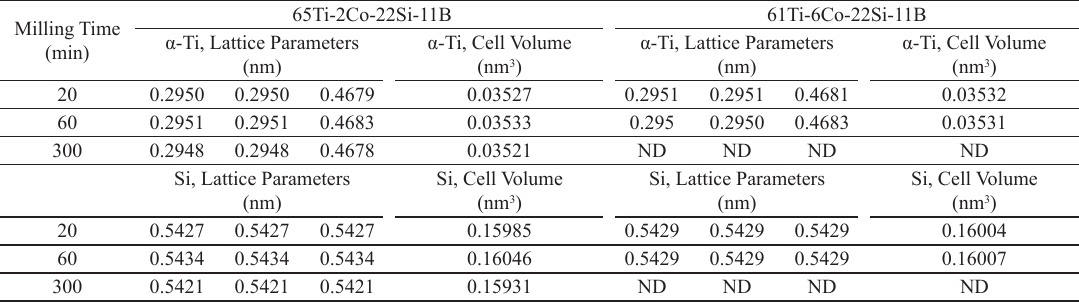
Table 2. Lattice parameters and unit cell volume of α-Ti and bcc-Si determined by Rietveld refining of Ti-Co-Si-B powders milled at different times. Milling Time